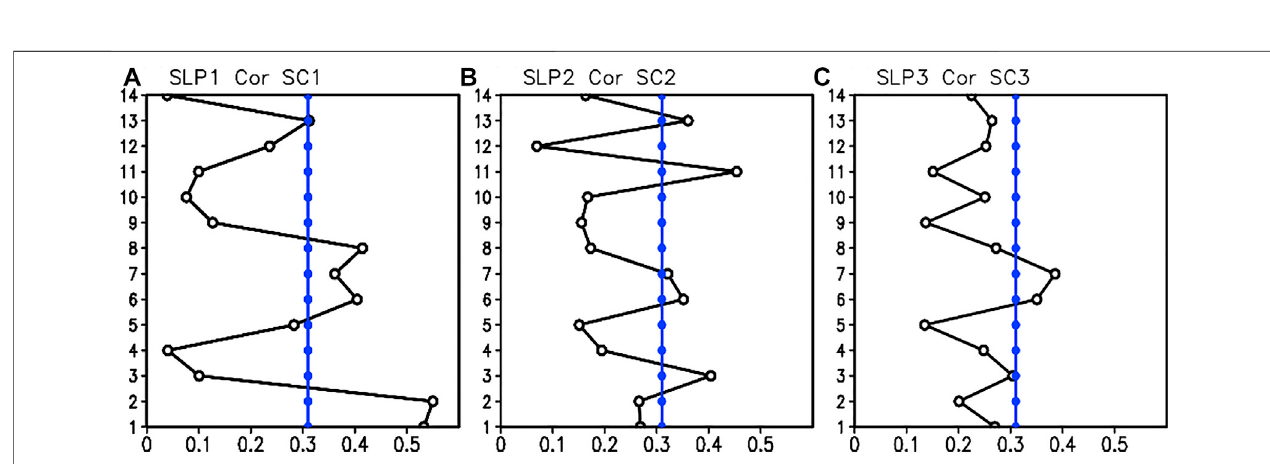
FIGURE 15 | The correlation coef fi cient between expansion coef fi cient time series of DJF SLP and ON snow cover in the fi rst (A) , second (B) , and third (C) SVD mode for individual 41-year subintervals. The blue line indicates the value signi fi cantly exceeding the 95% con fi dence level.